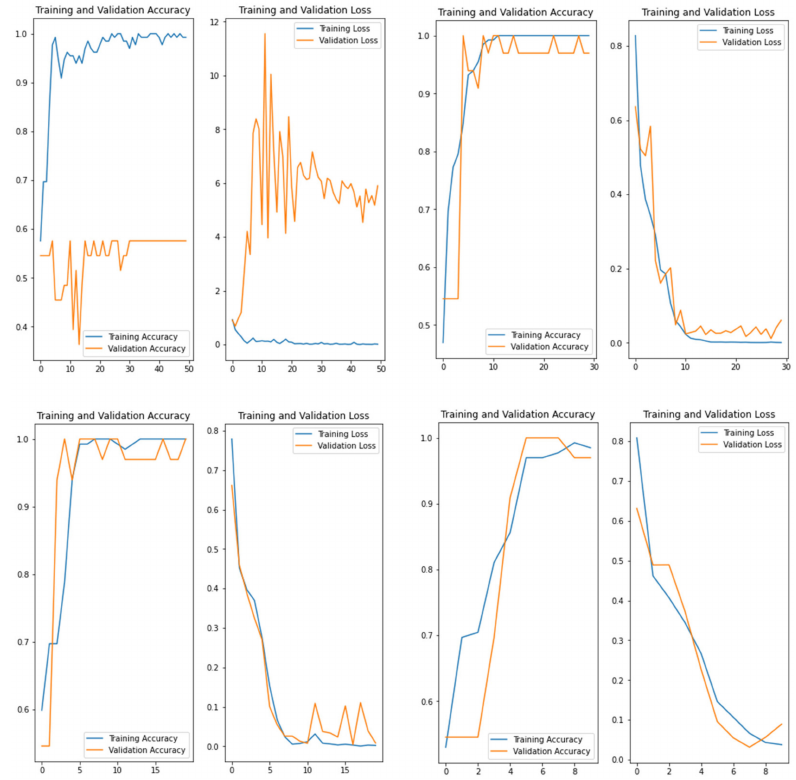
Figure 4. Illustration of model accuracy rate for 50, 30, 20, and 10 epochs for DB1 dataset acquired using an optical sensor “V300” by CrossMatch.